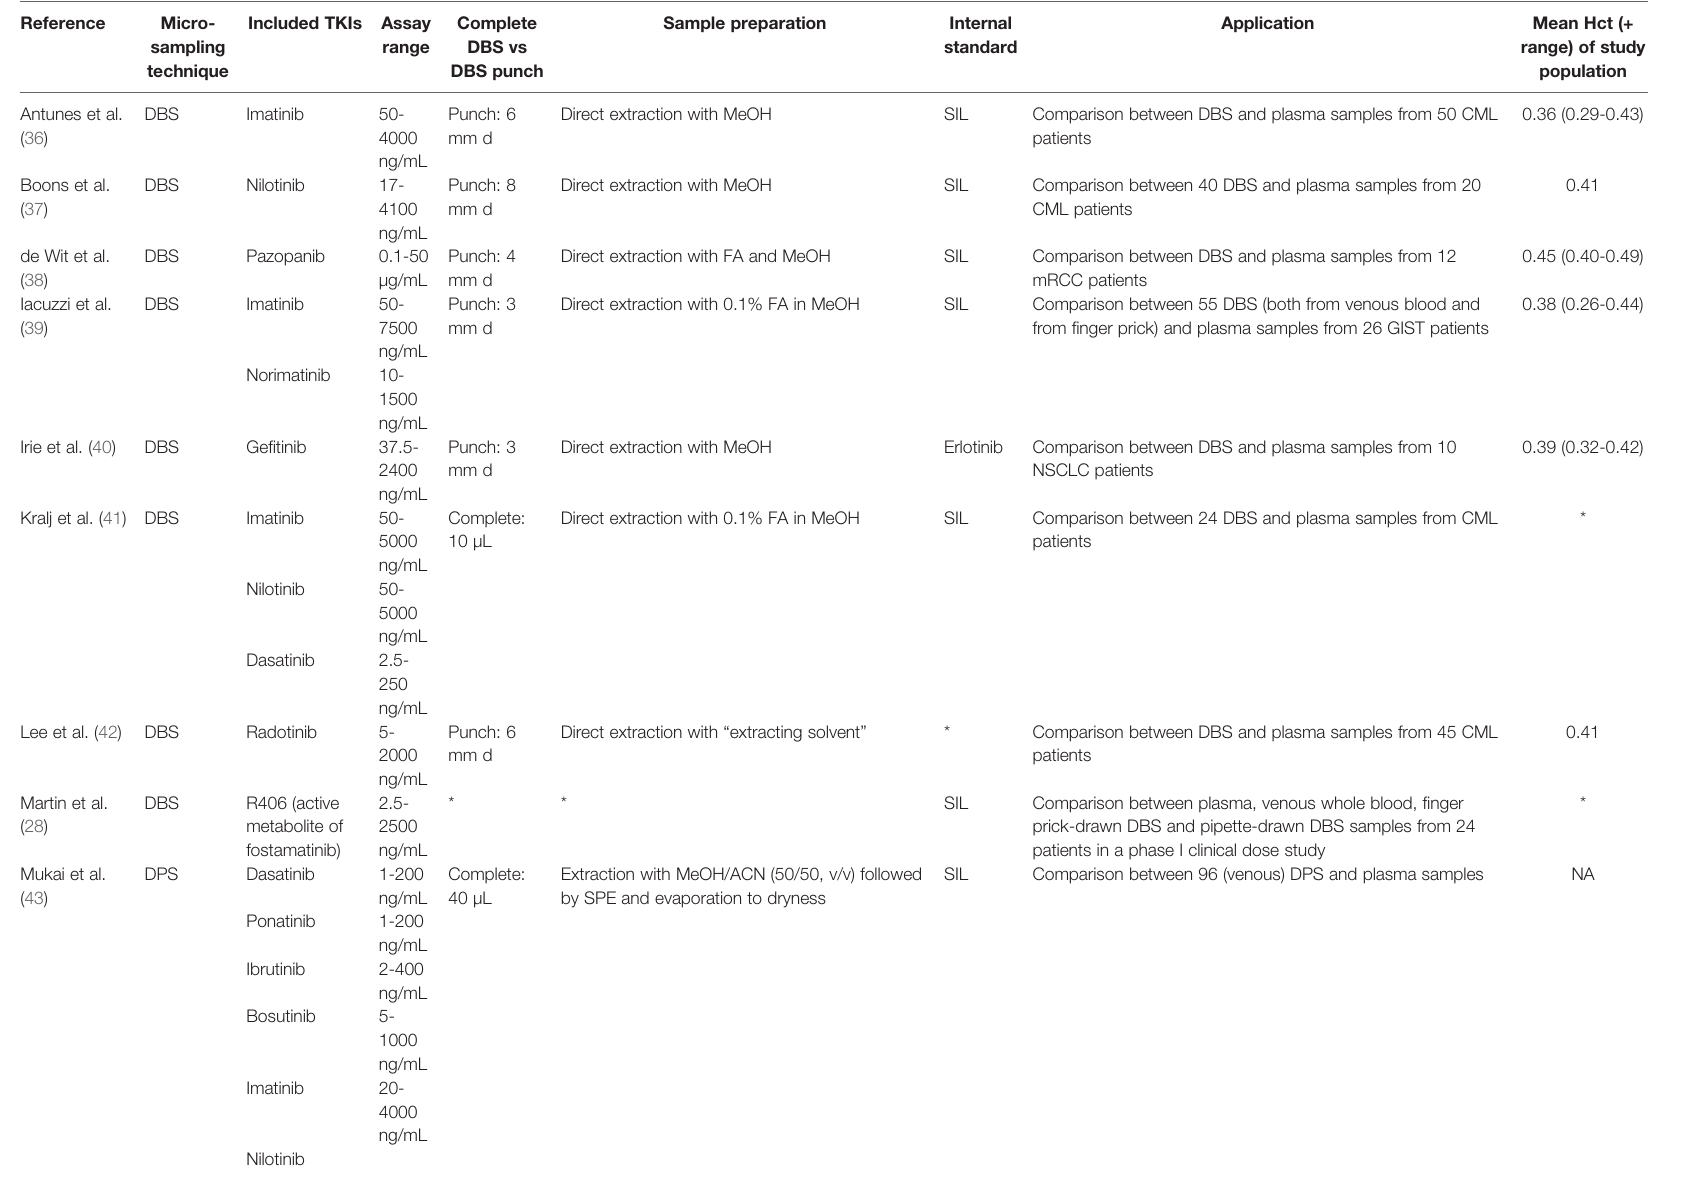
TABLE 2 | Overview of published microsample TKI-based methods in alphabetical order of the fi rst